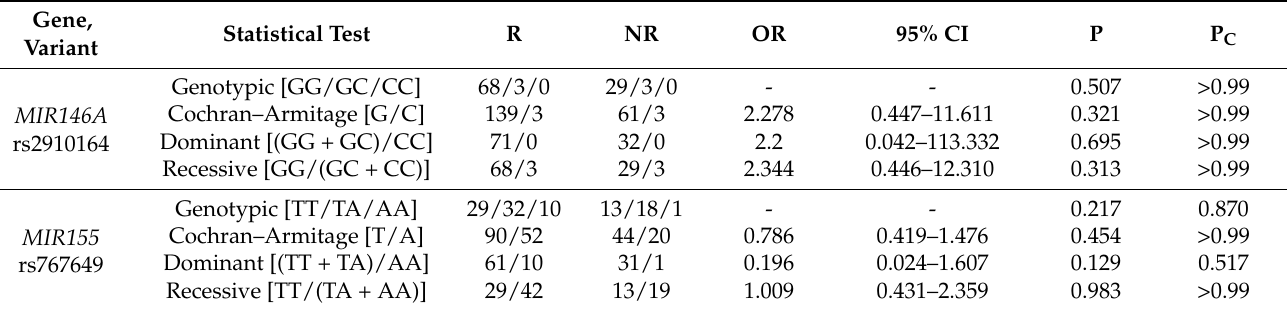
Table 3. Association between the studied genetic variants and response to anti-TNF therapy in the CD cohort.